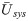
Hydrodynamic parameter axial distribution computed along the spine for cynomolgus monkeys.(A) Reynolds number, Re, (B) Flow rate amplitude, Qa, (C) Stroke Volume, SV, (D) left axis, Hydraulic diameter, Dh, right axis, Womersley number, α, (E) mean peak systolic, U¯sys, and diastolic, U¯dia, CSF velocity. Each line corresponds to mean value of each NHPs group with catheter located in the lumbar or cervical spine before or after catheter placement.